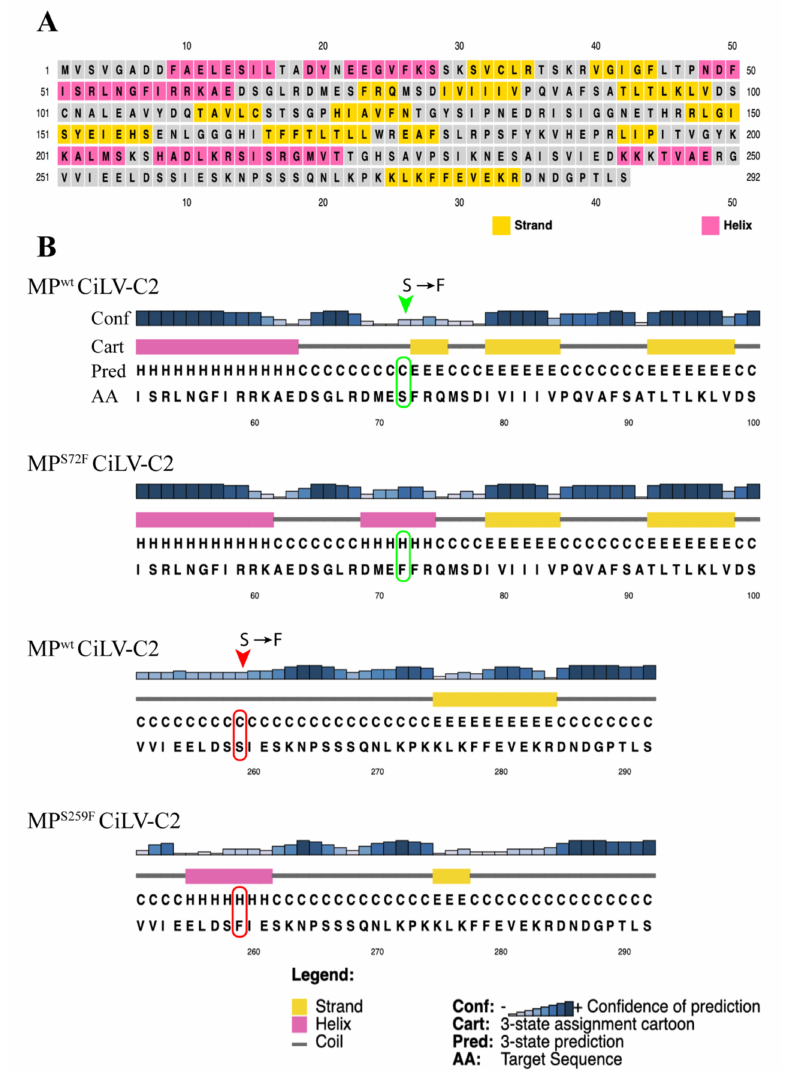
Figure 7. Annotated secondary structures of the CiLV-C2 MP WT , MP S72F , and MP S259F . ( A ) Sequence plot showing a global map of the secondary structures present in the CiLV-C2 MP WT . ( B ) PSIPRED cartoons show a comparison of secondary structures between CiLV-C2 MP WT with MP S72F and MP S259F in the MP regions (N- and C-terminus) where the mutations are present. The amino acids mutated are highlighted by the green (S → F, MP S72F ) and red (S → F, MP S259F ) arrows. The GenBank accession number of the CiLV-C2 strain L147V1 is